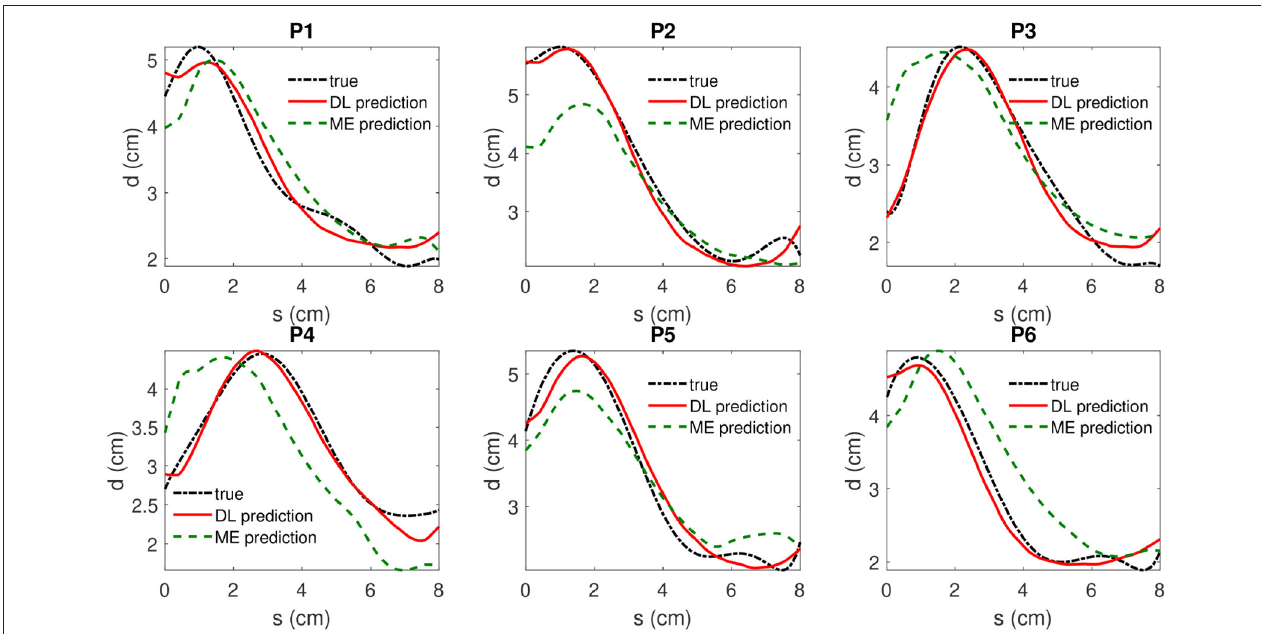
FIGURE 7 | The true value, the DBN model prediction and mixed-effects model prediction of IMDCs are shown in dotted dashed black (“true”), solid red(“DL prediction”), and dashed green lines(“ME prediction”), respectively. s denotes the coordinate of location along the centerline of AAA and d represents the associated maximum diameter measured by inscribed sphere